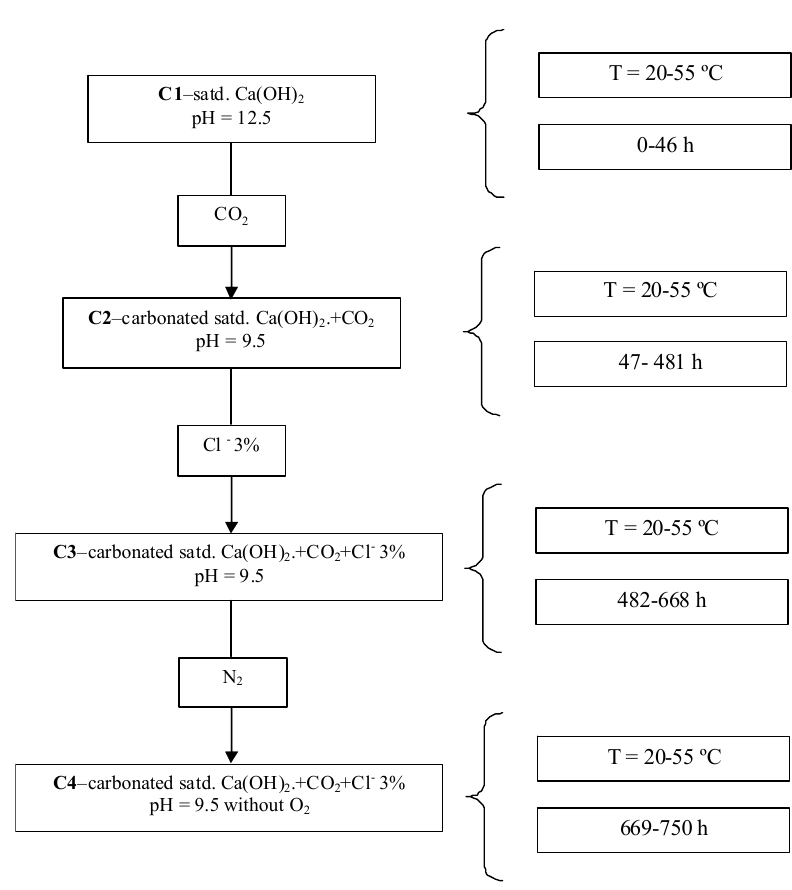
Figure 2. Scheme of the experimental conditions.